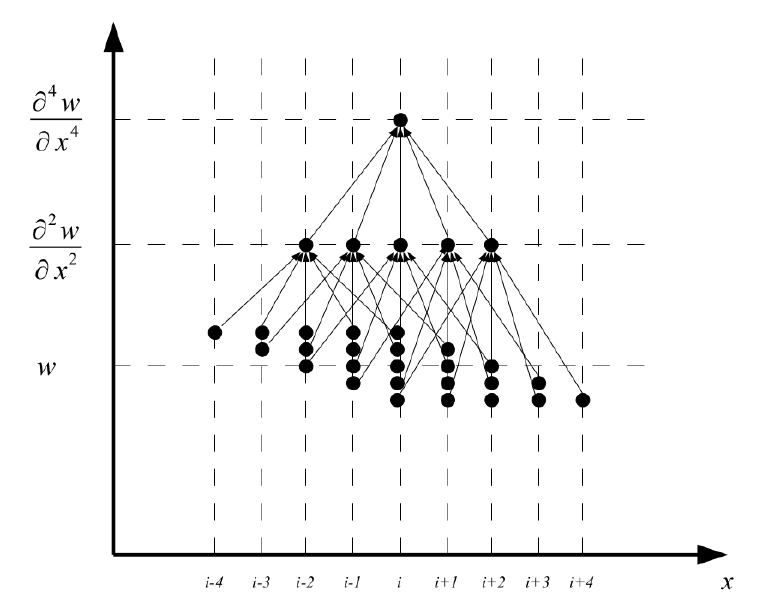
Figure 3. Fourth-order derivative bias stencil for wild oscillatory